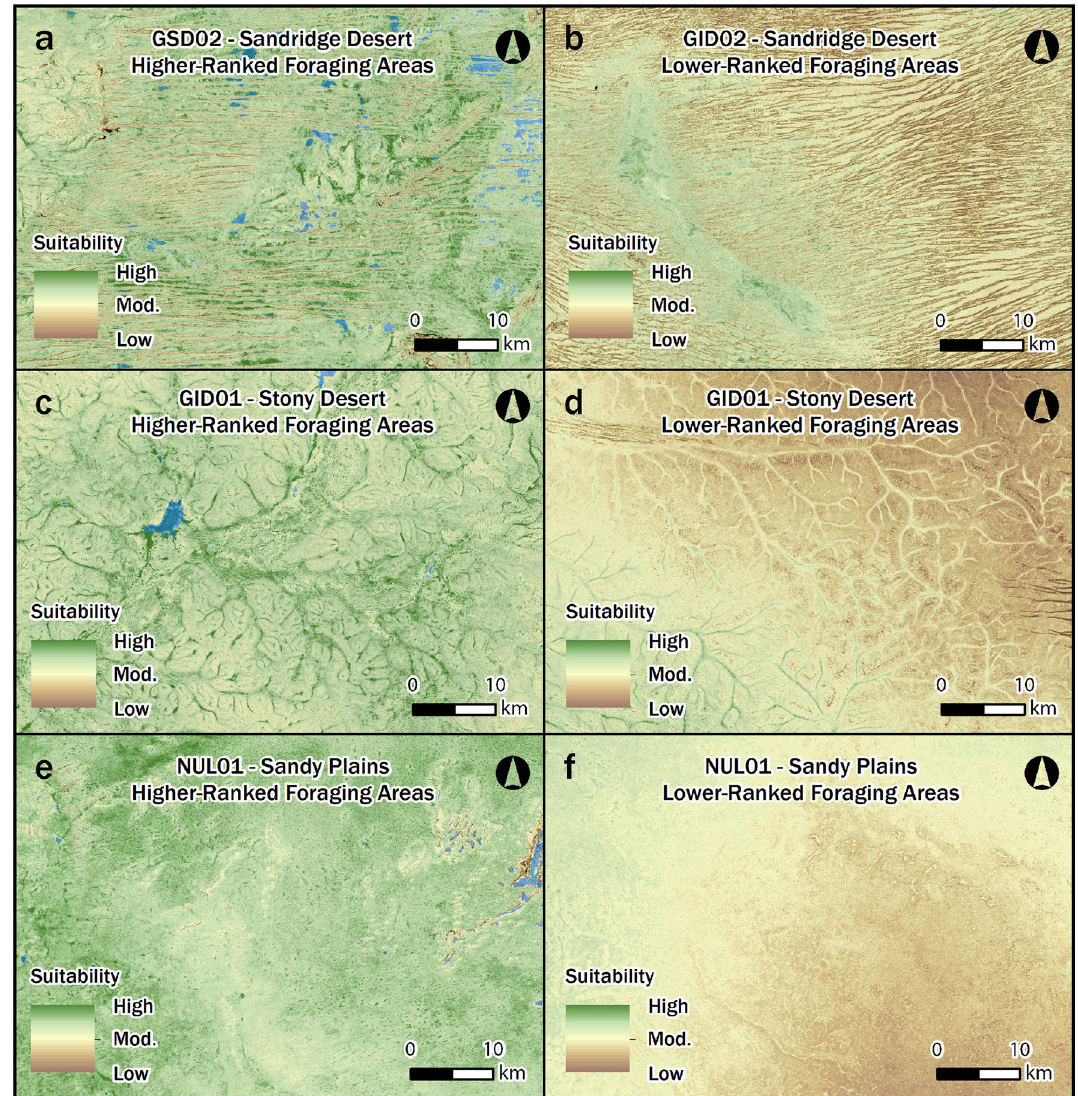
Figure 6. High resolution perspectives of various Western Desert landforms (e.g., sandridge, stony plain and sandy plain contexts) with generally higher-ranked and lower-ranked areas of foraging suitability. This figure illustrates the fine-grained scale of our habitat suitability model (Fig. 3), which has implications for better understanding localized land use behaviors. Juxtaposed areas, as mapped in Fig. 3 are: ( a ) Higher-ranked sandridge habitats vs. ( b ) lower-ranked sandridge land system. ( c ) Higher-ranked stony desert habitat vs. ( d ) lower-ranked stony desert areas. ( e ) Higher-ranked sandplain land systems vs. ( f ) lower-ranked plain habitats. Maps created in ESRI ArcGIS Desktop 10.5.1 (https:// deskt op. arcgis. com), linear stretch (1.0%) visualization. See “Methods” section for source raster areas of the Western Desert, our model clearly shows that foraging suitability is highly varied across all desert lowlands (Figs. 3, 4 and 6). In sandridge desert areas, proposed to have been a barrier at times in the past 4 , the model shows there are many well-watered and amply vegetated localities where good foraging is possible when rainfall is high and surface water is abundant (Fig. 6a). In this context, interdunal swales are hardly barriers to occupation because they can be lush with water, plant, and wildlife resources after local rain, and the energy expenditure required to walk along interdunal swales is low in comparison to the requirements needed to repeat- edly scramble across a sea of loose sands and undulating dunes. Thus, it seems entirely plausible that resident groups could navigate and forage in many dunefield areas by following a well-resourced network of swales during times of good environmental conditions. The fine-grained nature of this observation opens up the possibility that many sandridge deserts were not necessarily broad barriers to occupation and that precontact land use behaviors varied in different dunefield contexts. We also highlight that the resource-rich swale pattern is not found in all dune systems (Fig. 6b), and it is plausible that some of these areas were periodic barriers to occupation, as previously suggested in more gener- alized ecological models 4 . There are substantial areas of sandridge desert, especially within central areas of the